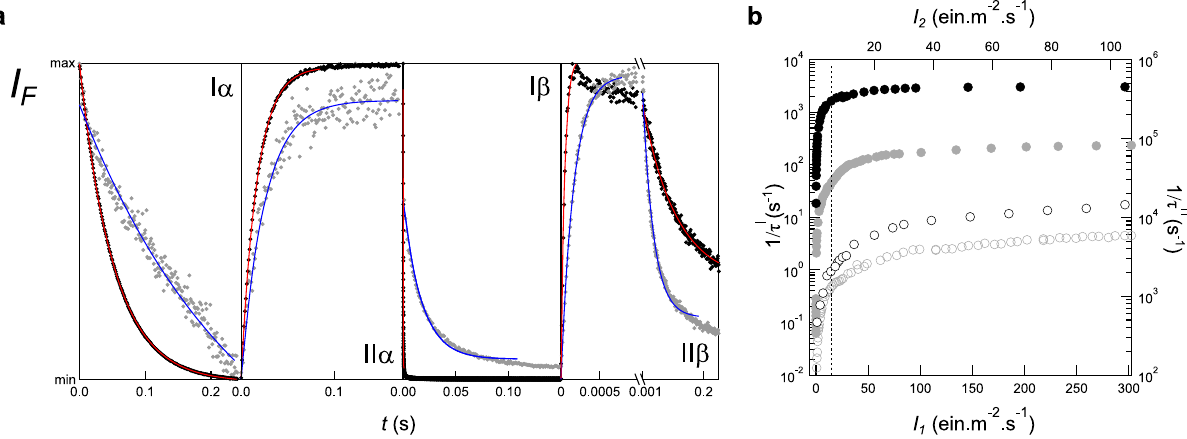
Fig. 2 LIGHTNING data collection on RSFP solutions. a Four illuminations involving lights at λ 1 = 488 and λ 2 = 405 nm at respective intensities I 1 and I 2 ( I 1 , I 2 in Ein m − 2 s − 1 ; I α : I 1 = 0.1, II α : I 1 = 0.1 and I 2 = 0.1, I β : I 1 = 50, II β : I 1 = 50 and I 2 = 20) yield four fl uorescence evolutions I F (markers; each scaled by the difference between the maximal and minimal values) at λ 3 = 525 nm. Whereas I α , II α , and I β provide a single characteristic time after monoexponential fi tting (lines), up to two characteristic times can be retrieved in II β depending on the frequency and time window of fl uorescence acquisition; b Inverse of the characteristic time obtained for a series of illuminations I (disks) (II (circles), resp.) versus light intensity I 1 ( I 2 , resp. at I 1 = 0.2 Ein m − 2 s − 1 ). The vertical dotted line separates the low-intensity regime for which the rate-limiting step is photochemical from the high-intensity regime for which the rate- limiting step is thermal. 1 (grey markers and blue lines) and 2 (black markers and red lines) are representatives of slow and fast photoswitching RSFPs